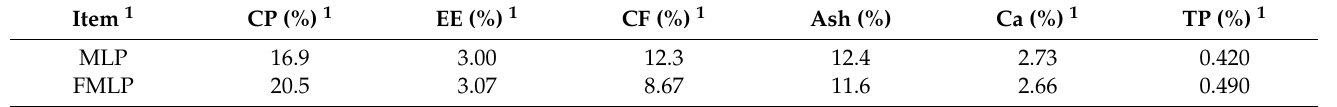
Table 1. Routine nutrient analysis of MLP and FMLP.